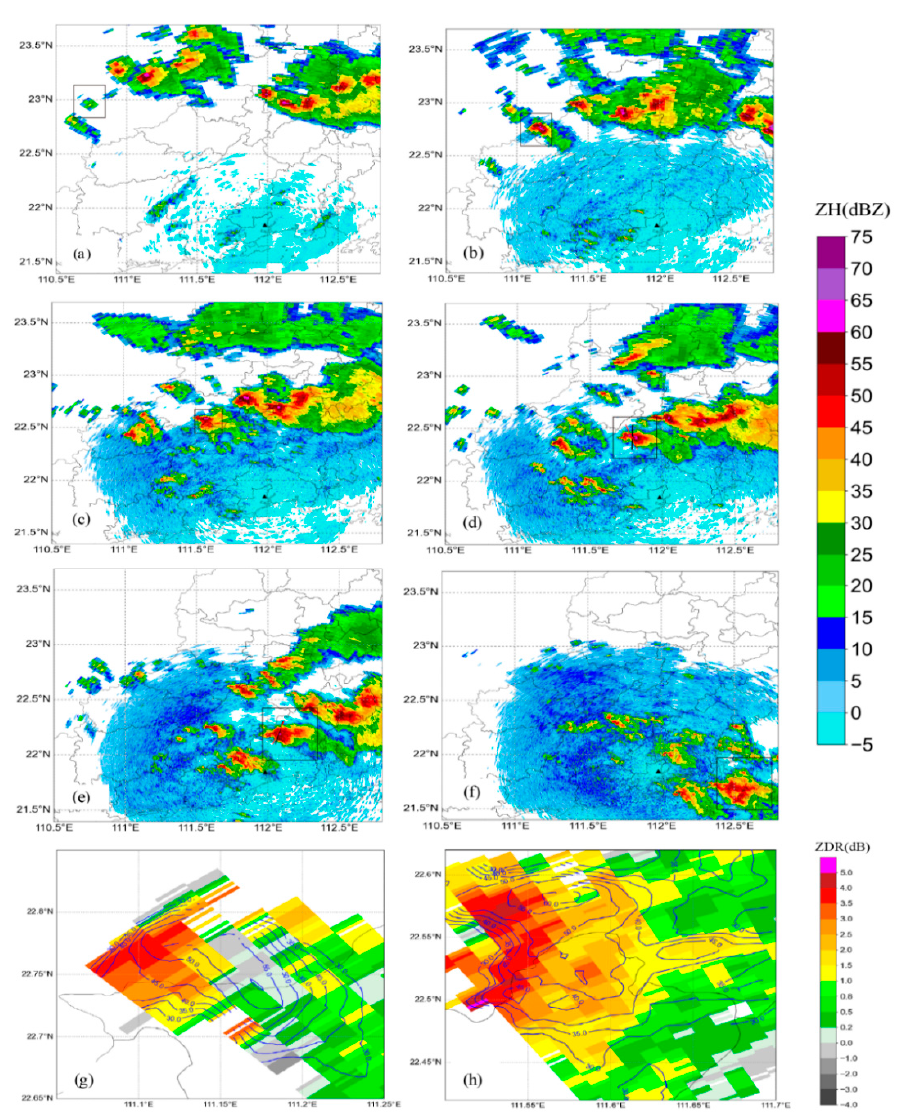
Figure 5. Mosaics of reflectivity radar at 1.5° elevation at ( a ) 19:00, ( b ) 20:30, ( c ) 21:30, ( d ) 22:06, ( e ) 23:00, and ( f ) 01:00 LST. The plan view of the 1.5° elevation reflectivity factor and ZDR at ( g ) 20:30 LST, as indicated by the solid black wireframe, and at ( h ) 21:30 LST, as indicated by the solid black wireframe, where the colored part is ZDR, and the reflectivity factor is marked with black contour lines. Municipal borders are superimposed as black contours.